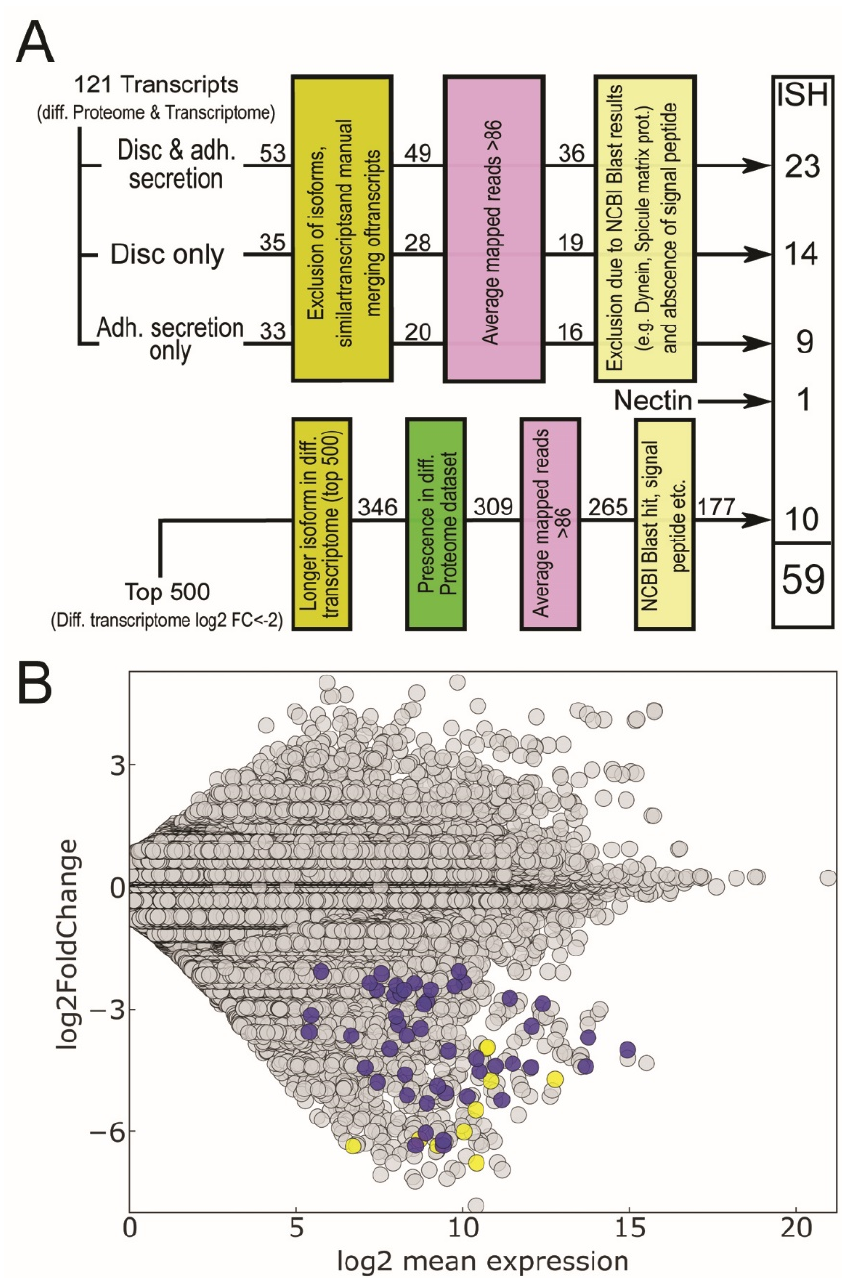
Figure 5. In situ hybridization candidate gene selection. ( A ) Candidate gene selection workflow. Initially, 121 transcripts were found in proteome data from disc and adhesive secretion samples as well as being over-expressed in the tube feet discs in the di ff erential transcriptome. Exclusion of isoforms and similar transcripts, low expressed transcripts and exclusion of genes with non-adhesion related NCBI BLAST hit reduced in situ candidates to 49 transcripts. Additionally, 10 transcripts were selected for in situ hybridization that were di ff erentially expressed but was not identified in the di ff erential proteome dataset. ( B ) Di ff erential gene expression analysis. Transcripts that were selected for in situ hybridization are highlighted in blue (di ff erential proteome and di ff erential transcriptome selection) and yellow (di ff erential transcriptome only candidate